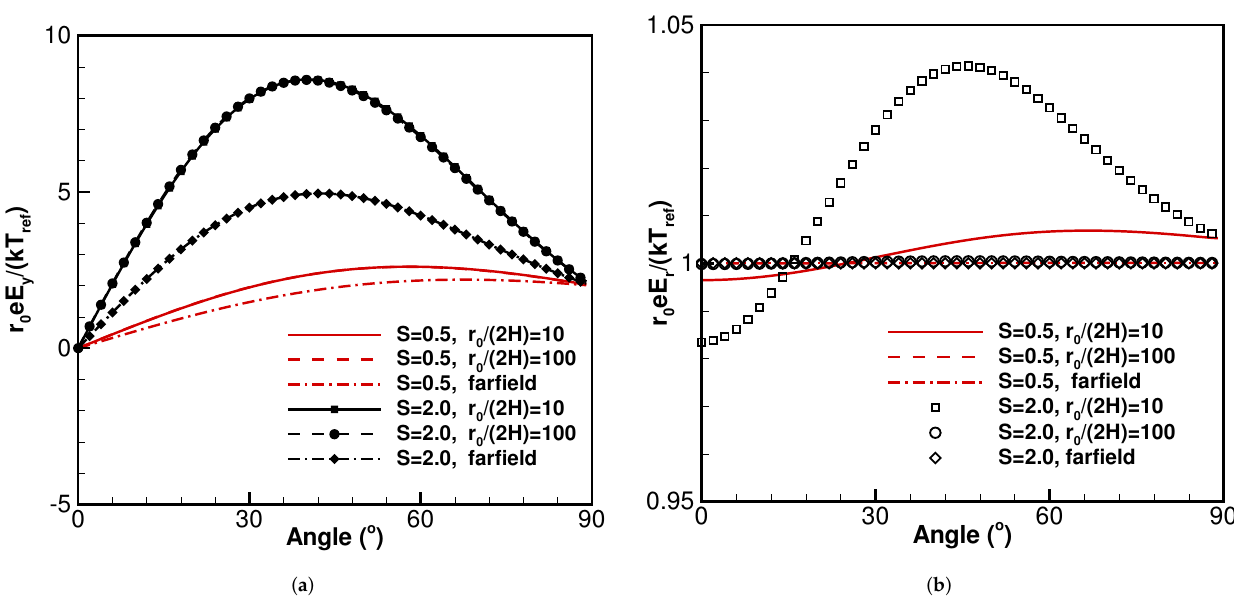
Figure 6. ( a ) Normalized electric field component, er 0 E y / ( kT 0 ) , at different angles; ( b ) Normalized electric field component, er 0 E r / ( kT 0 ) , at different